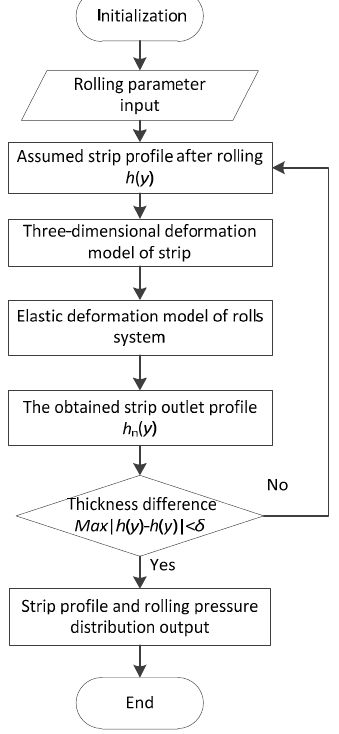
Figure 3. Roll and strip calculation model flow chart.